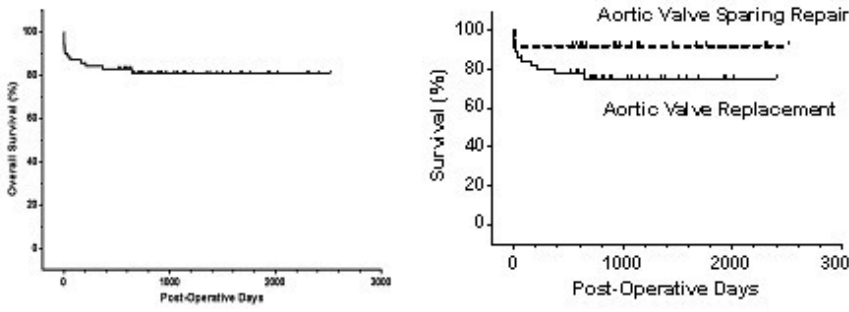
Fig. 1A - The overall survival. 1B. Kaplan Meier curve, comparing the survival between two groups (95% CI, 1,225 to 0,1265,